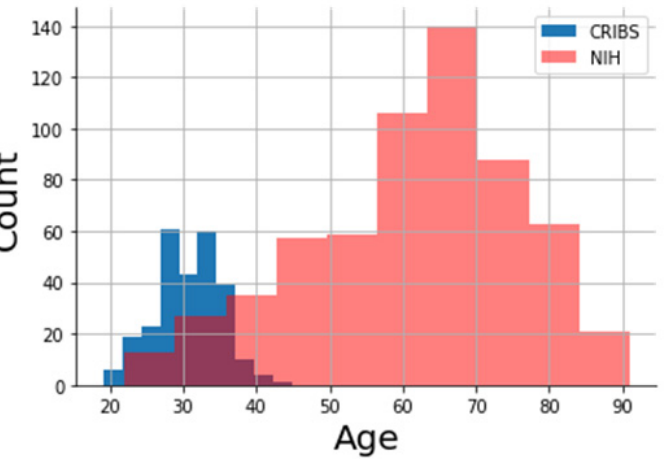
Figure 1. Age distribution of the two cohorts. The CRIBS cohort (blue colored histogram) consists of 266 pregnant women, while the NIH cohort consists of 344 non-pregnant women (pink colored histogram).